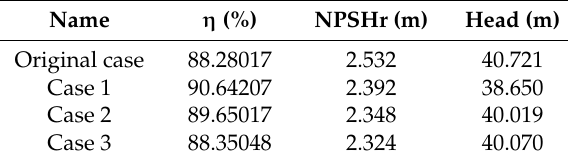
Table 7. Comparison of original case and best optimal